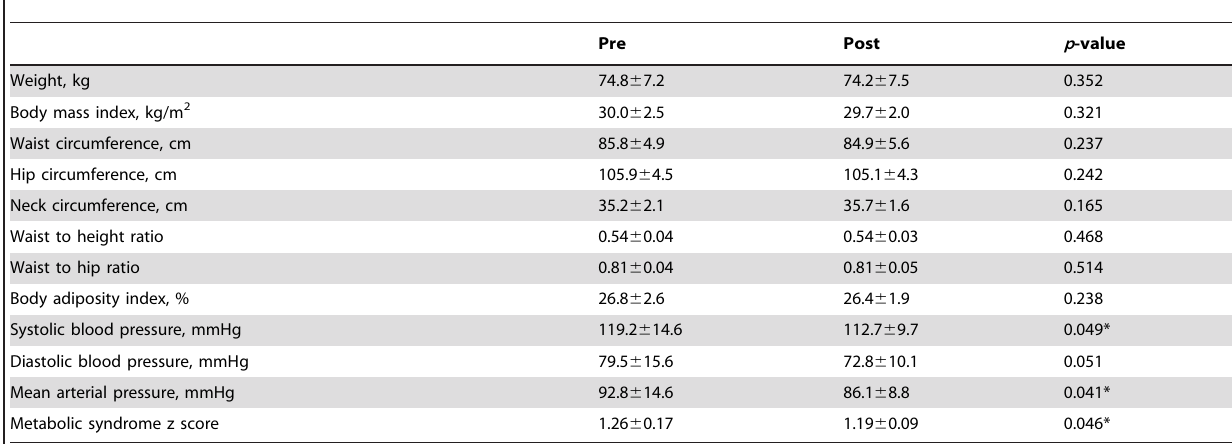
Table 1. Anthropometric and hemodynamic characteristics of the subjects (n=13) before and after the training program (mean 6